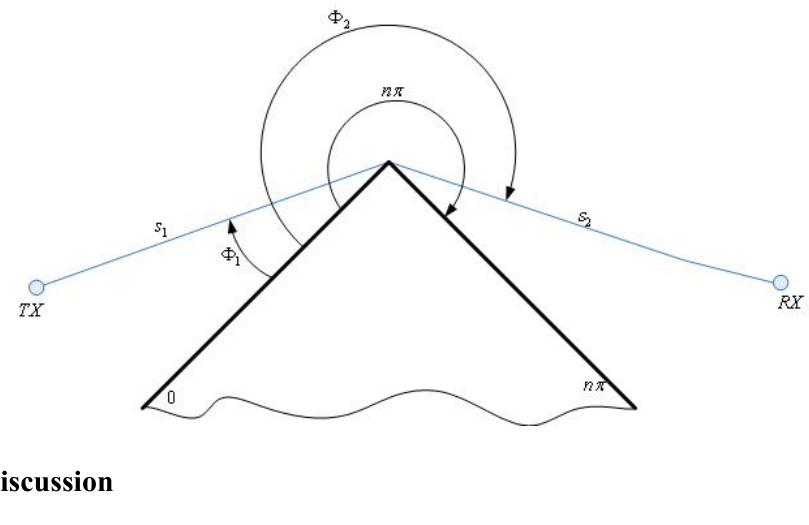
Figure 4. Geometry for wedge diffraction coefficients.